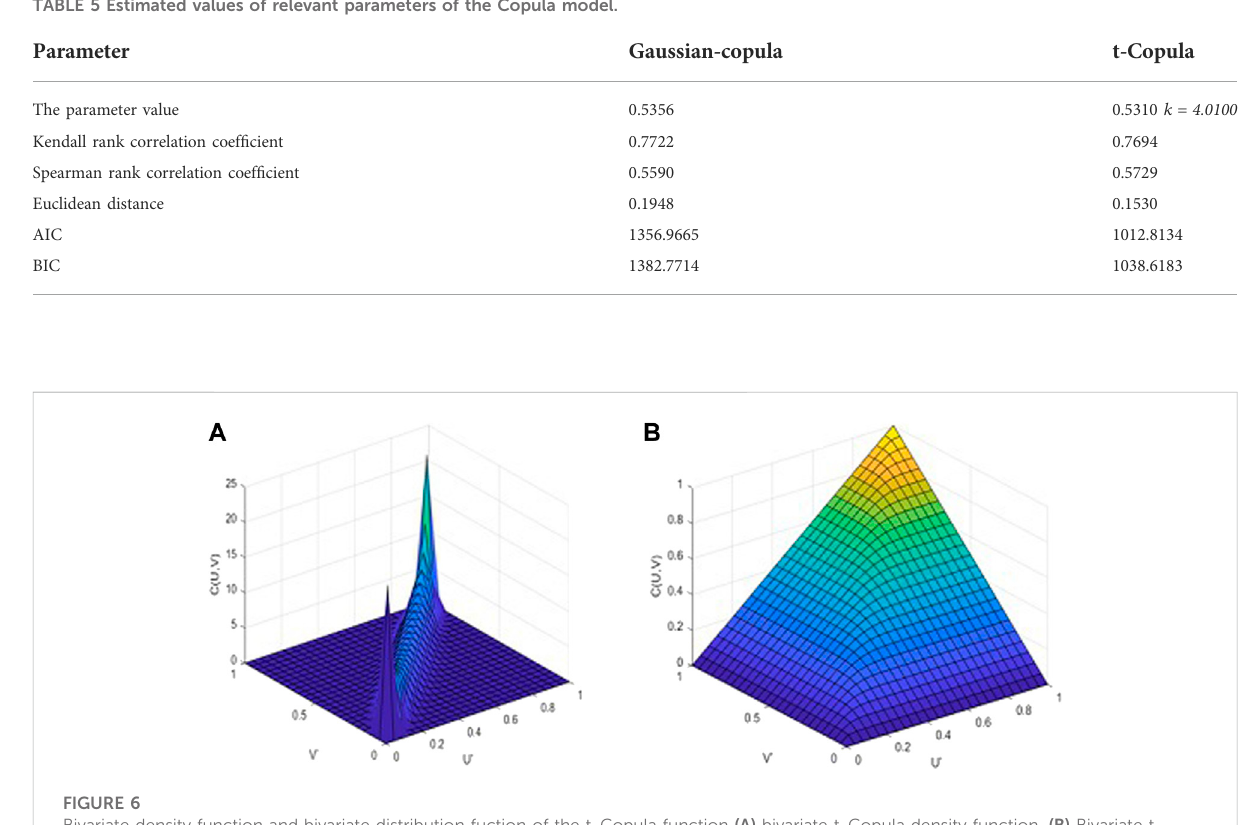
TABLE 5 Estimated values of relevant parameters of the Copula model.